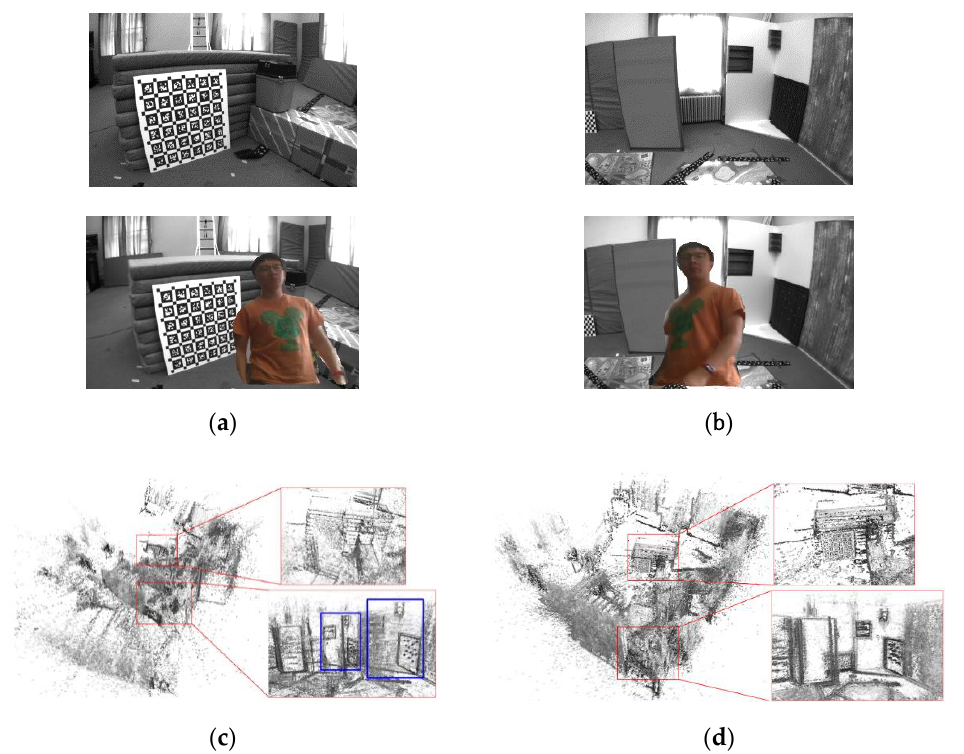
Figure 17. 3D point cloud maps of indoor scene and partial enlarged maps constructed by Dynamic-DSO and DSO in V101_syn sequence. ( a ): Calibration board shown in V1_01 and V101_syn. ( b ): Room corner shown in V1_01 and V101_syn. ( c ): point cloud map constructed by DSO. ( d ): point cloud map constructed by Dynamic-DSO.